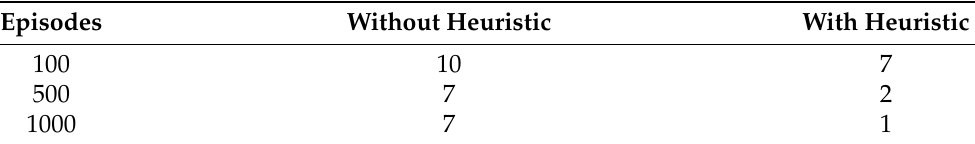
Table 2. Number of sessions without a positively graded weight set by using and omitting the heuristic. Episodes